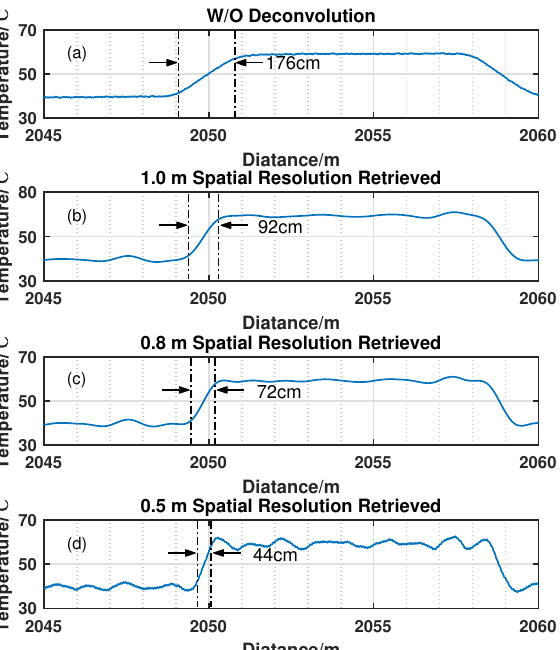
Figure 9. The resolved temperature distributions around the heated 9-m fiber coil ( a ) without deconvolution, ( b ) deconvoluted with parameter K = 8 × 10 − 3 , ( c ) deconvoluted with parameter K = 3 × 10 − 3 , ( d ) deconvoluted with parameter K = 2 × 10 − 4